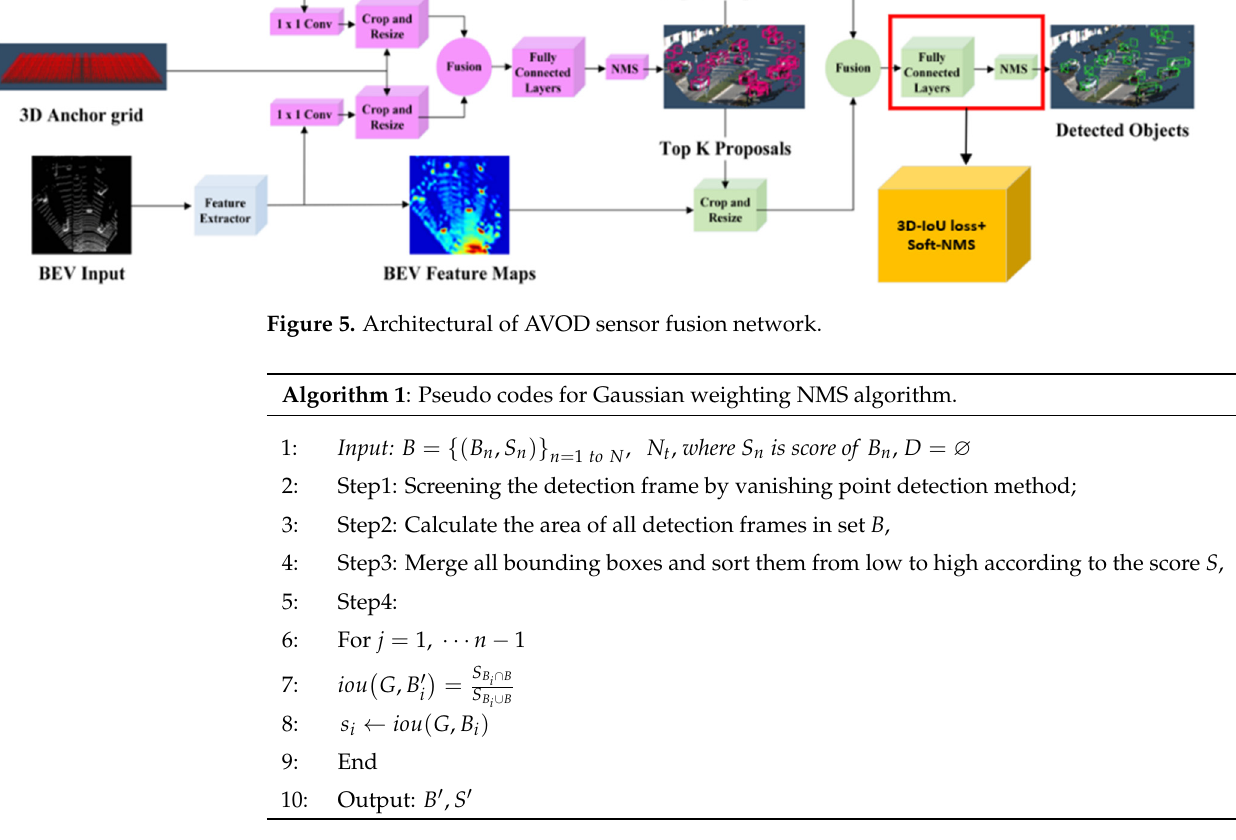
Algorithm 1 : Pseudo codes for Gaussian weighting NMS algorithm